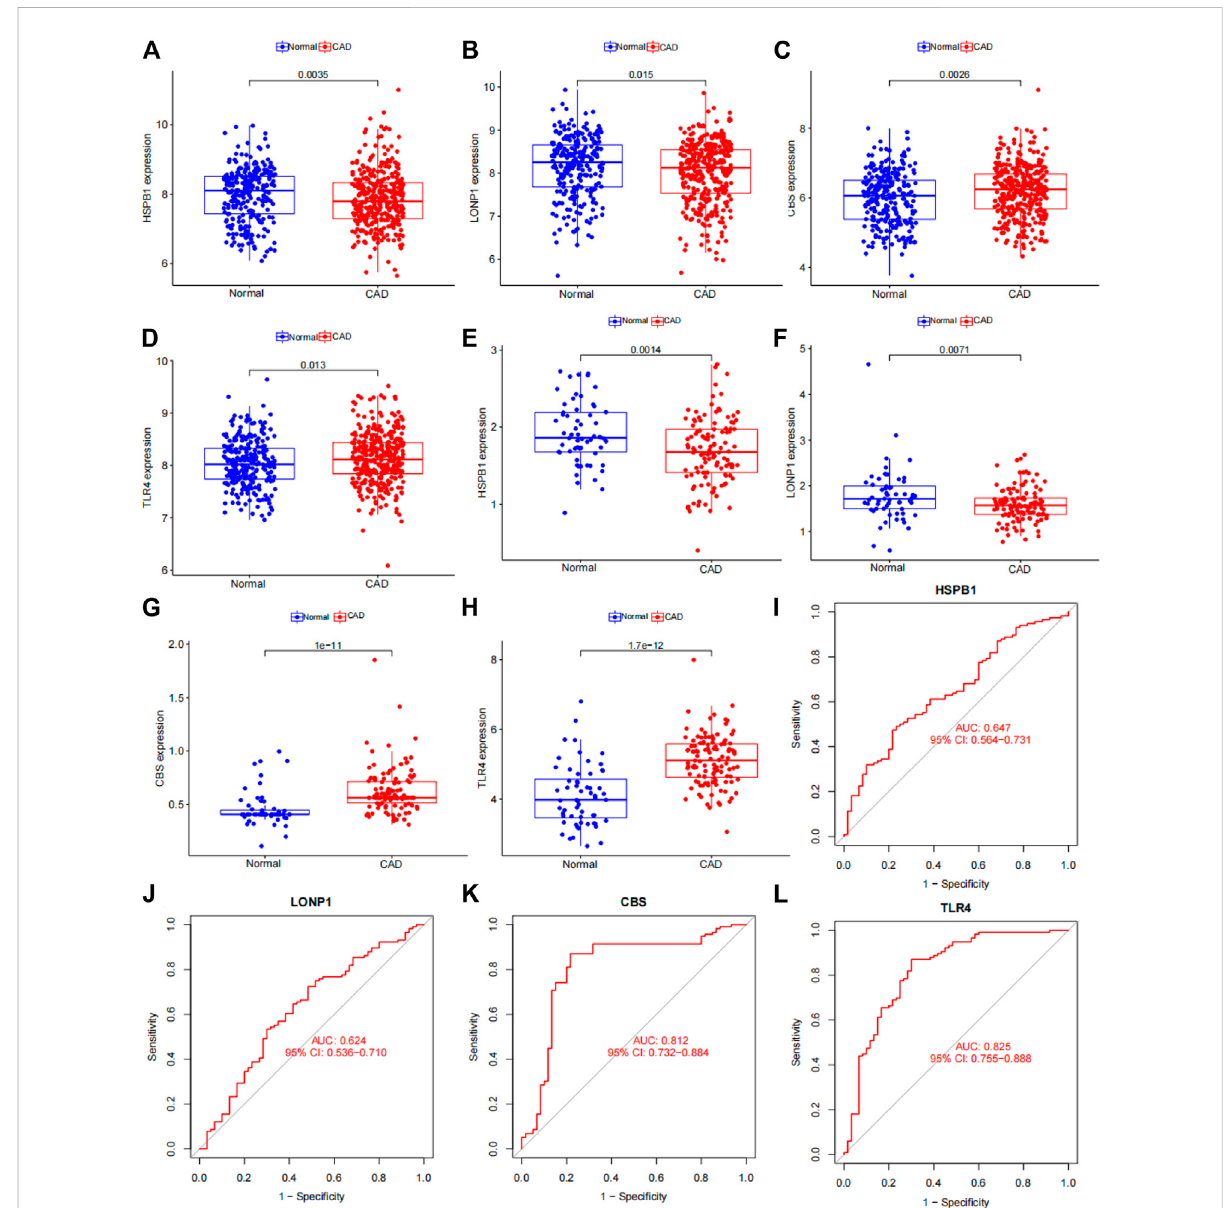
FIGURE 13 Veri fi cation of 4 subgroup-speci fi c genes. (A) HSPB1 expression in patients with CAD samples compared with normal samples in the merged dataset. (B) LONP1 expression in patients with CAD samples compared with normal samples in the merged dataset. (C) CBS expression in patients with CAD samples compared with normal samples in the merged dataset. (D) TLR4 expression in patients with CAD samples compared with normal samples in the merged dataset. (E) HSPB1 expression in patients with CAD samples compared with normal samples in the GSE180083 dataset. (F) LONP1 expression in patients with CAD samples compared with normal samples in the GSE180083 dataset. (G) CBS expression in patients with CAD samples compared with normal samples in the GSE180083 dataset. (H) TLR4 expression in patients with CAD samples compared with normal samplesintheGSE180083dataset. (I) Performanceof HSPB1 expressioninCADdiagnosisinthetestdataset. (J) Performanceof LONP1 expressionin CAD diagnosis in the GSE180083 dataset. (K) Performance of CBS expression in CAD diagnosis in the GSE180083 dataset. (L) Performance of TLR4 expression in CAD diagnosis in the GSE180083 dataset. The distinction was considered good when the AUC value was between 0.8 and 0.9 and exceptional when the AUC value was greater than 0.9. ROC: receiver operating characteristic; AUC, area under the ROC